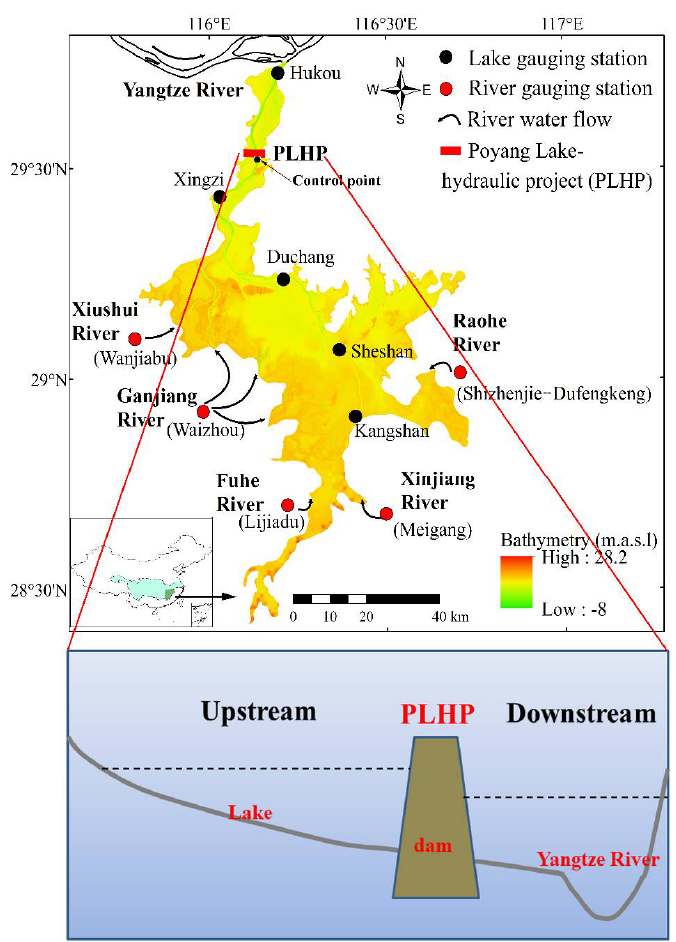
Figure 2. Topographic map (30 m × 30 m in year 2010) and major inflow rivers in the floodplain system of Poyang Lake. The lower panel shows schematic diagram of the PLHP in the river–lake system.